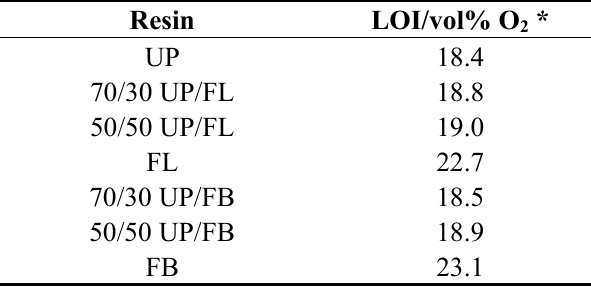
Table 3. LOIs of cured resin and resin blends.